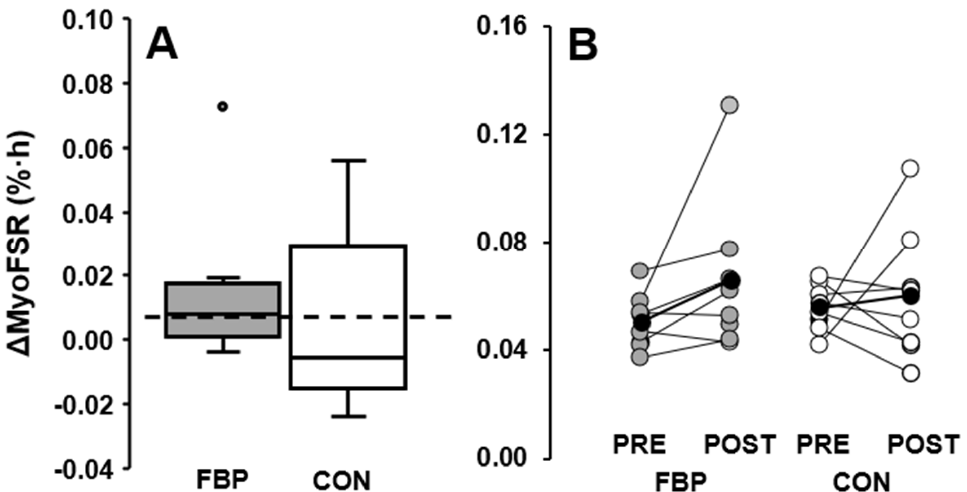
Figure 3. Resting postprandial myofibrillar fractional synthetic rate (myoFSR) change (% · h − 1 ). ( A ), change values (post-test pre-test) boxplot; statistical outlier (1.5 × interquartile range, grey circle). ( B ), pre-test (PRE) to post-test (POST) values; data are individual participants from fava bean protein (FBP, grey circles), control (CON, white circles) groups; group means (black circles).